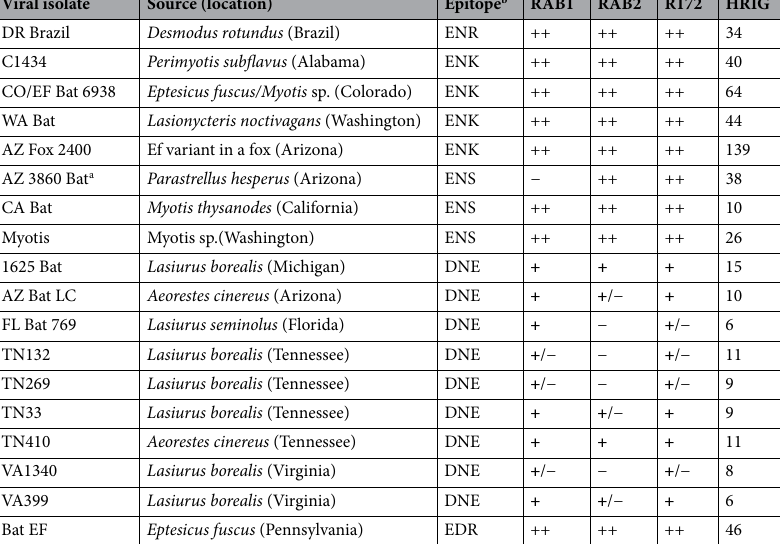
Table 3. RFFIT of RAB1, RAB2 and R172 against North America bat isolates. ++EC 50 < 1 µg /mL. + EC 50 > 1 µg /mL. + /− EC 50 > 100 ug/ml. − Not neutralized by HuMAb at the highest concentration tested. HRIG potency IU/mL against given isolate. a Lab-acquired mutation I338T identified in 3860 Bat following cell